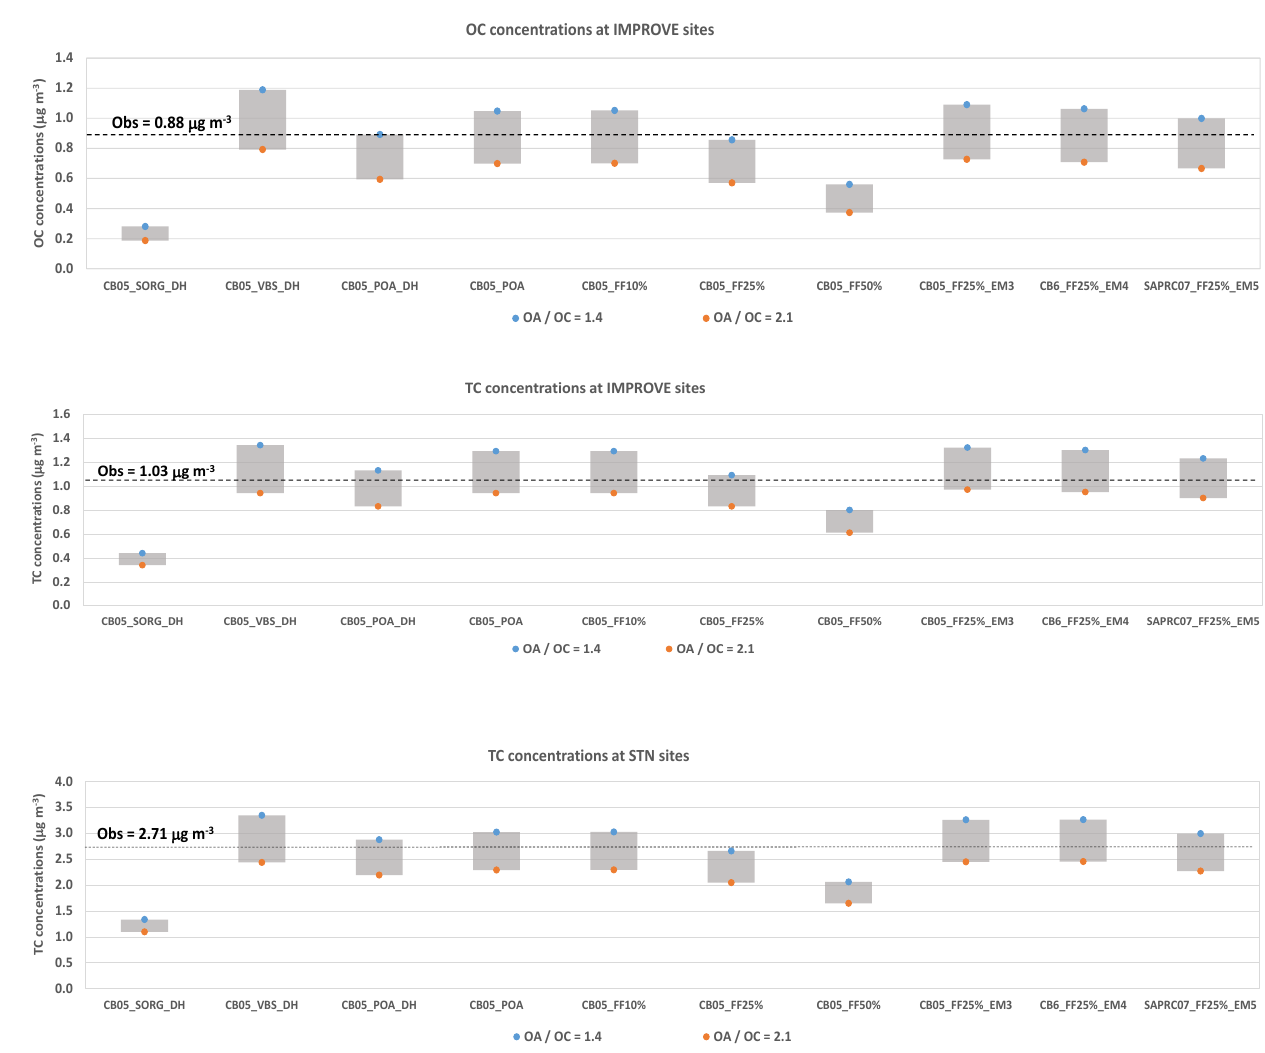
Figure 1. Sim OC and TC concentrations against observations from IMPROVE and STN under two OA / OC ratios, 1.4 and 2.1, resulting in a range of possible OC or TC values denoted by the gray bars. The obs OC or TC is denoted by the horizontal dotted line.